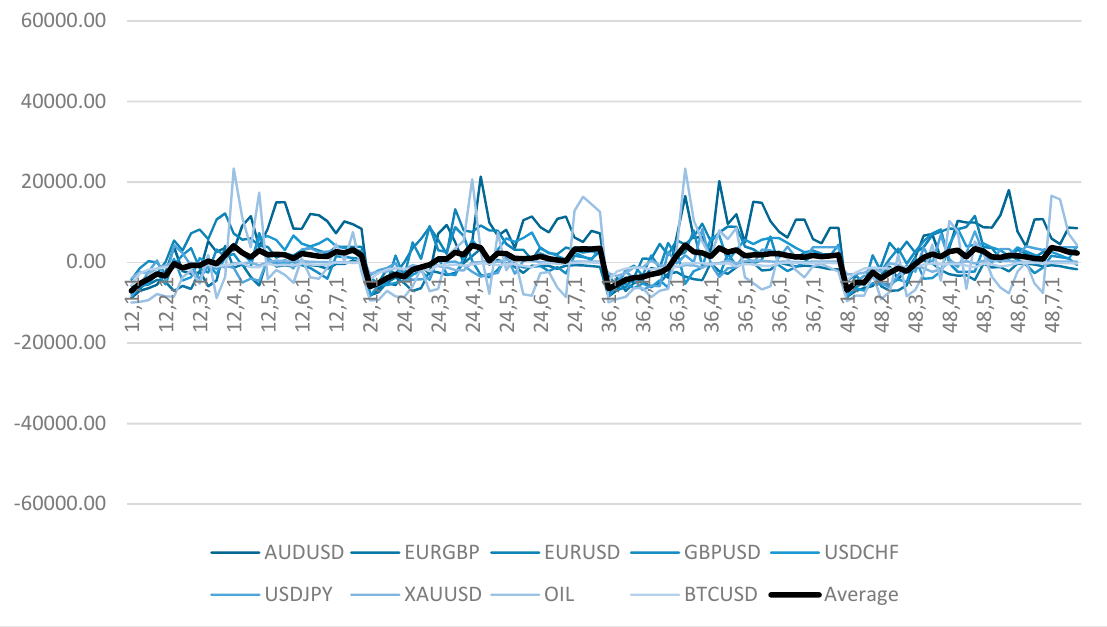
Figure 15. Drawdown, as percentage of equity, of experiment (g) for various combinations of N, x , y . The general picture is the same as the case of (f). For small values of x , the profits are diminished, while for larger values of x , they tend to stay constant and approach the Simple MACD’s results. Additionally, large values of y tend to have lower drawdown. Finally, we examined (h) an MACD Expert Advisor with a sliding and variable Stop Loss zone ± x × ATR(N), with a new value of ATR used at hourly intervals as described in Section 2.3.7 and a constant new position prevention zone at ± y × ATR(N). We tested every combination of parameters for N:{12,24,36,48}, x :{1,2,3,4,5,6,7}, and y :{1,2,3,4}. The Net Profits for each asset for every combination of N, x , y have been outlined in Figure 16 and Drawdown in Figure 17.